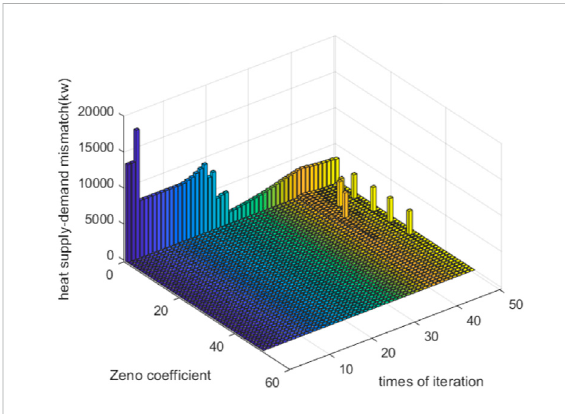
FIGURE 10 Power mismatch with larger